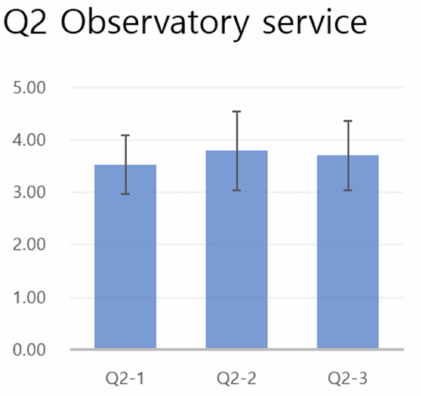
Figure 12. Results showing user satisfaction with the observatory service.